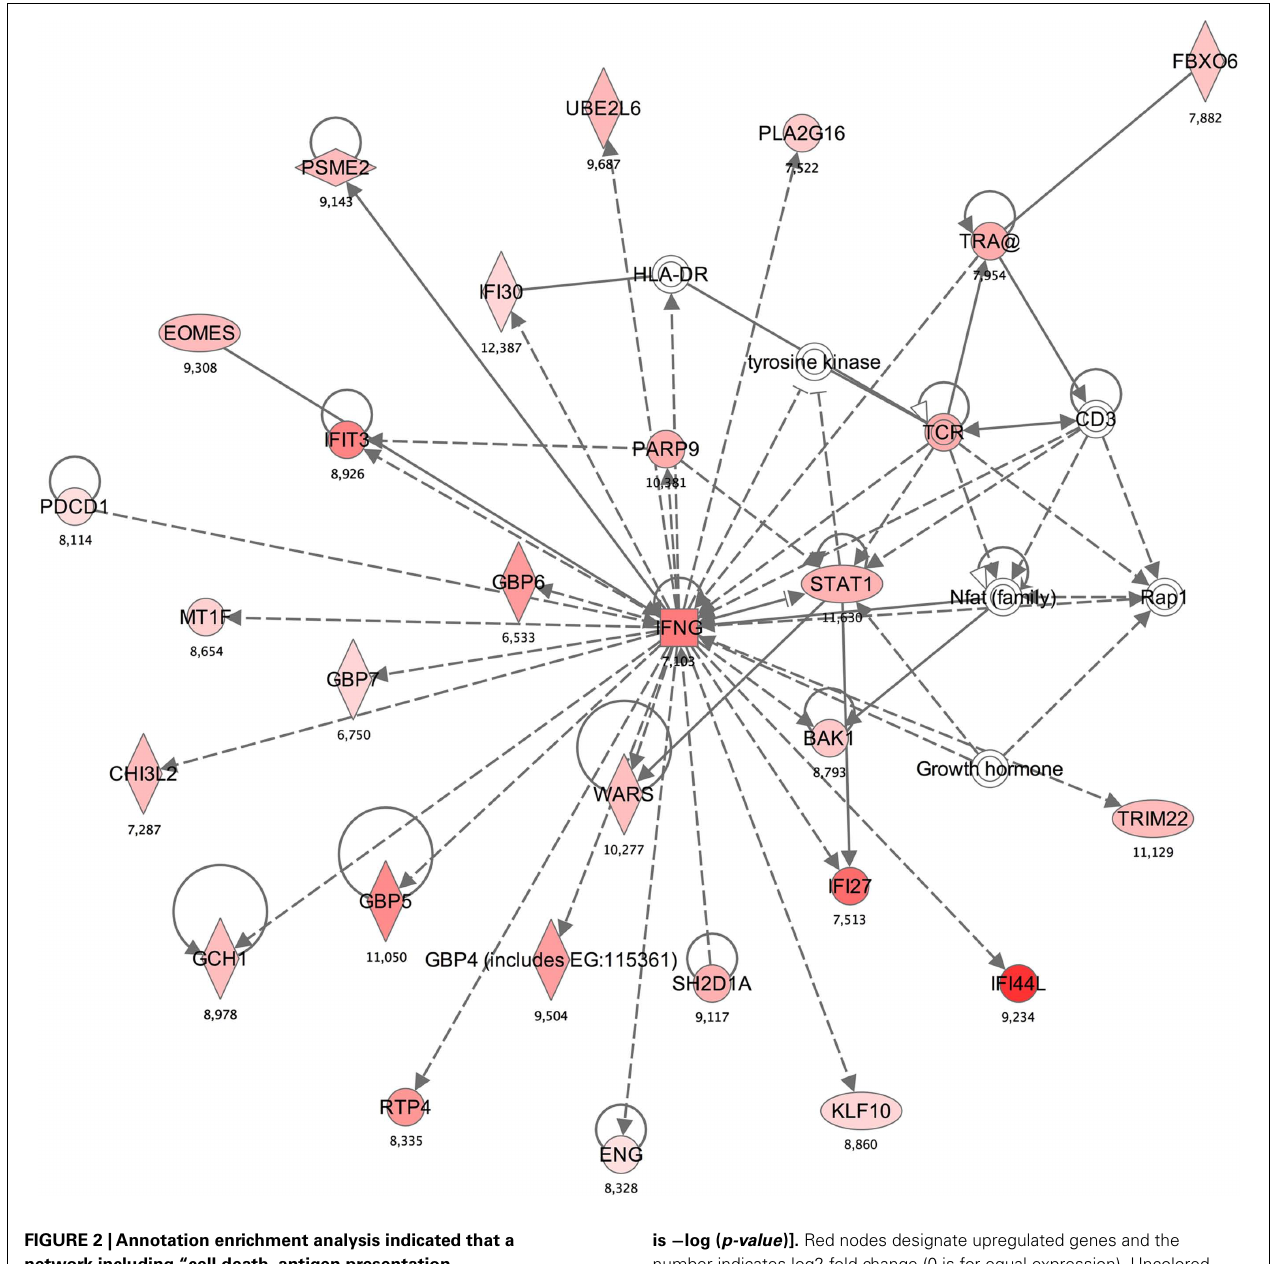
FIGURE 2 |Annotation enrichment analysis indicated that a network including “cell death, antigen presentation, neurological disease” gene functions is significantly enriched in the subjects with methcathinone abuse [score 47, score